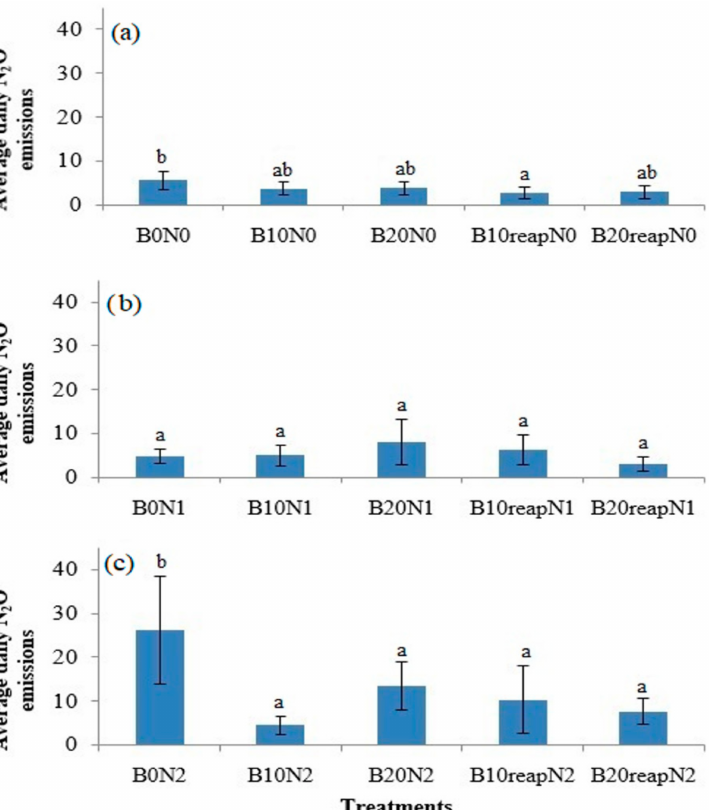
Figure 3. Daily average N 2 O emissions from unfertilized N0 ( a ), fertilized soil N1 ( b ), and fertilized soil N2 ( c ), with and without biochar. Error bars denote the standard errors of the mean ( n = 3). Different letters in the graph indicate significant differences between different treatments, according to the Tukey